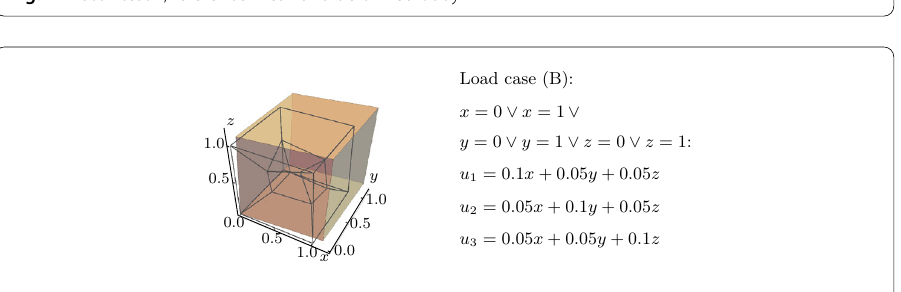
Fig. 2 Patch test 1; reference mesh and deformed body